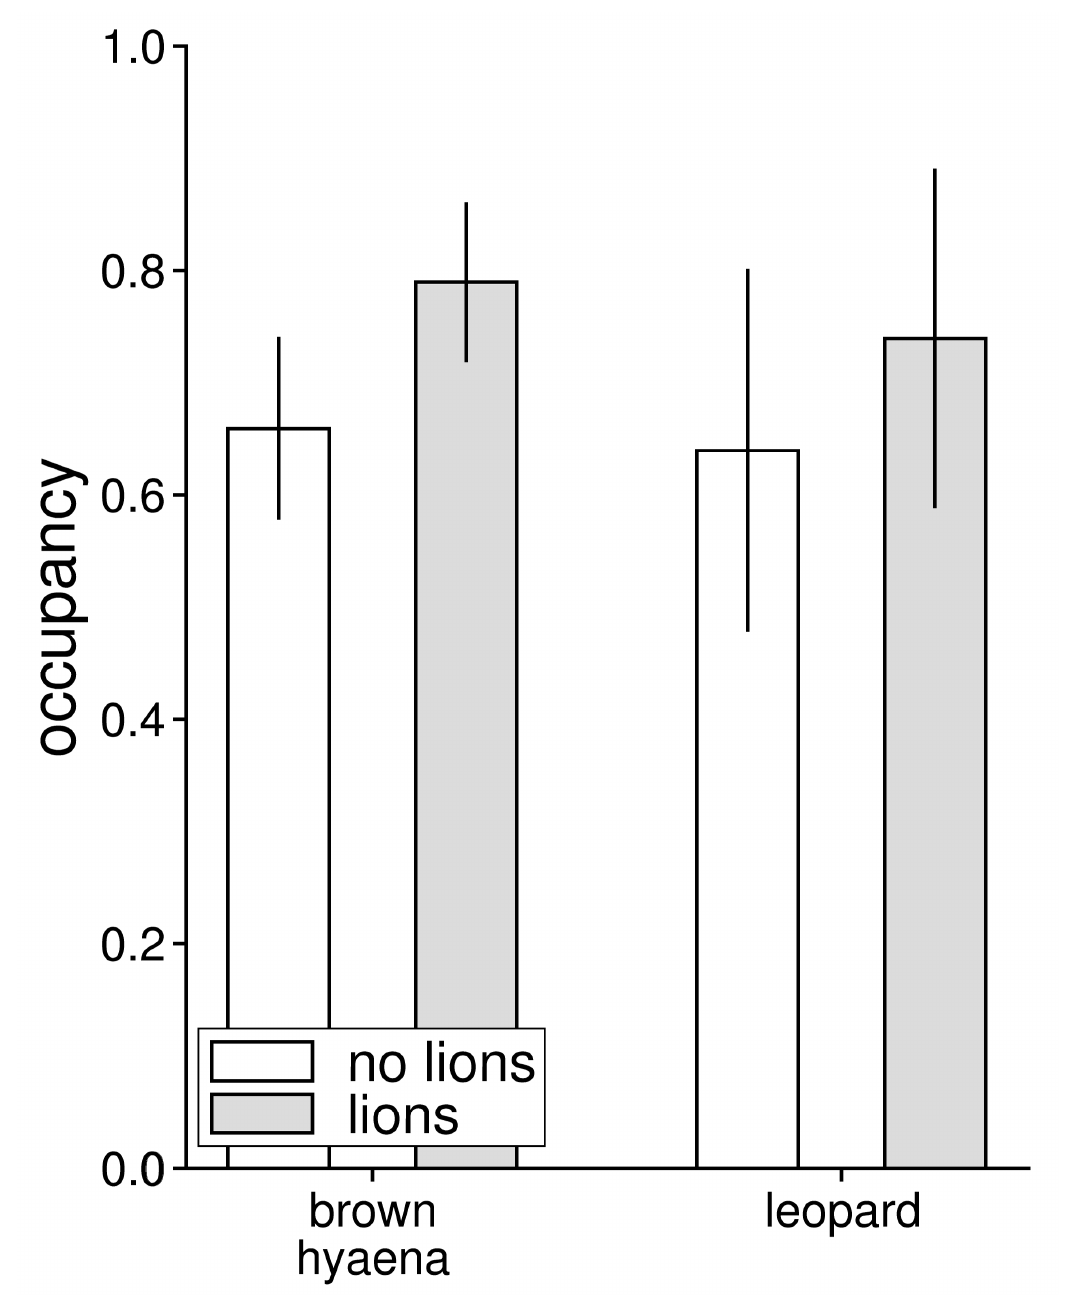
Figure 2. Predicted probability of occupancy for brown hyaenas and leopards in a reserve without (Lapalala) and with (Welgevonden) lions present. Occupancy estimates are based on single species occupancy models, which accounts for imperfect detection, based on data from camera trap